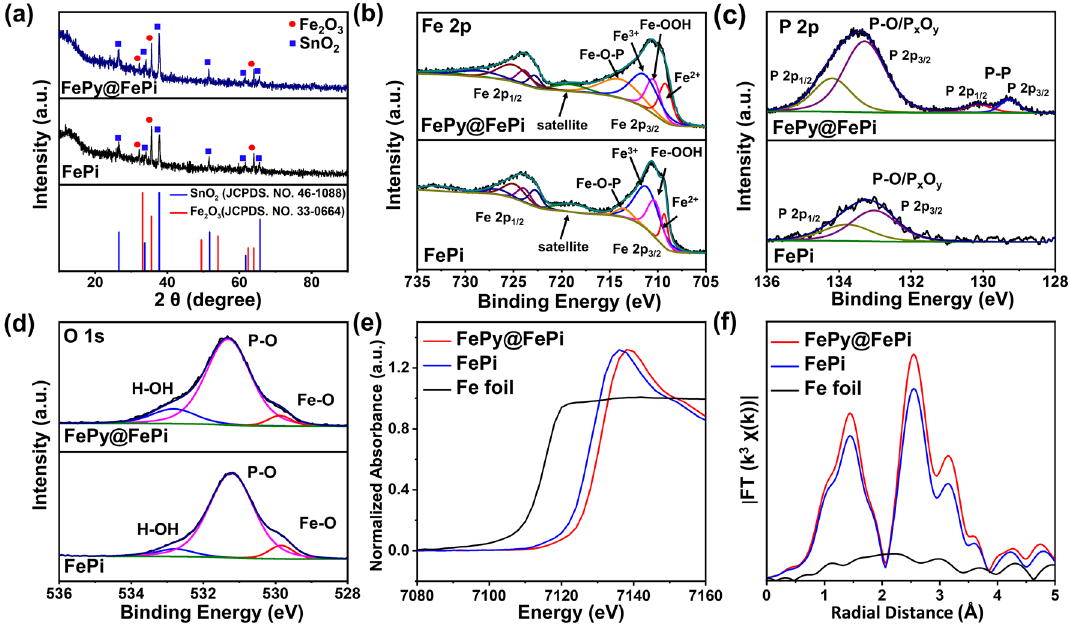
Fig. 2 a XRD patterns of FePi and FePy@FePi. b, c, and d XPS spectra of Fe 2 p, O 1 s , and P 2 p of FePi, and FePy@FePi. e, f XANES and EXAFS spectra of Fe foil FePi, and